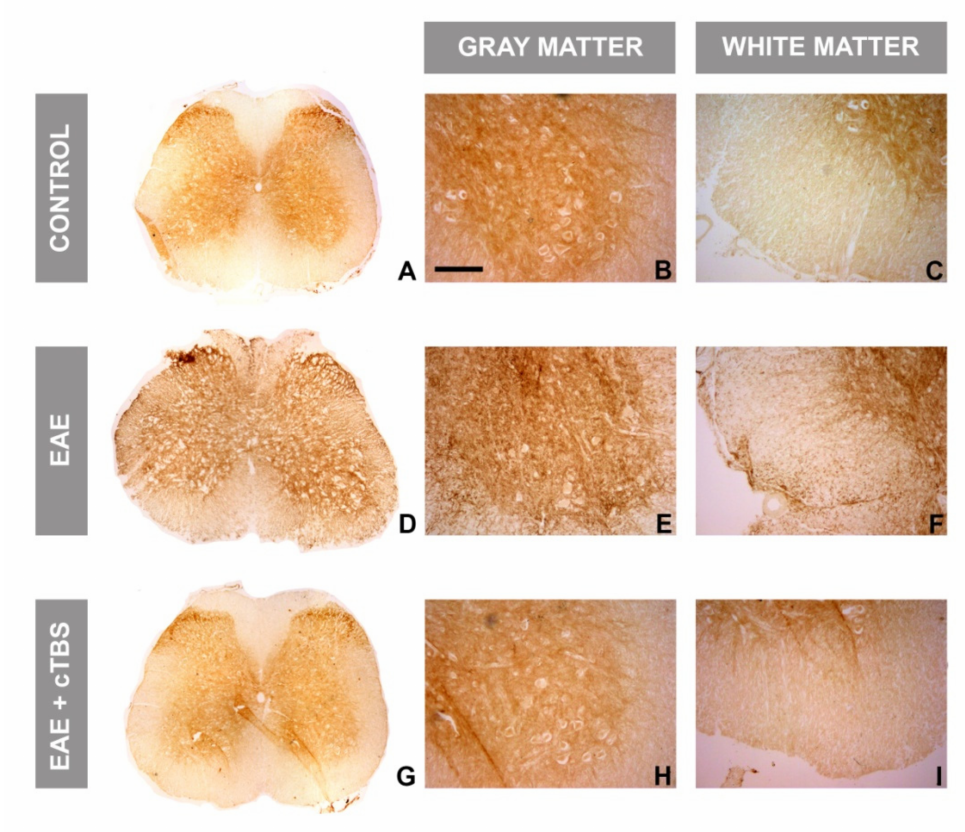
Figure 7. Effects of CTBS treatment on AMP-based enzyme histochemistry in lumbar spinal cords of EAE rats. Enzyme histochemistry in the presence of AMP as a substrate labeling structures that exhibit eN/CD73 activity in the spinal cord of control, EAE, and CTBS-treated EAE sections. Control sections ( A ) exhibited diffuse staining patterns localized mainly in gray matter ( B ), while white matter was devoid of staining. ( C ) EAE sections reveled ( D ) a marked increase in eN/CD73 activity localized in gray ( E ) and white matter ( F ). After CTBS protocol ( G ), faint activity was observed in both gray ( H ) and white matter ( I ), similarly to control sections. Scale bar corresponds to 50 µ